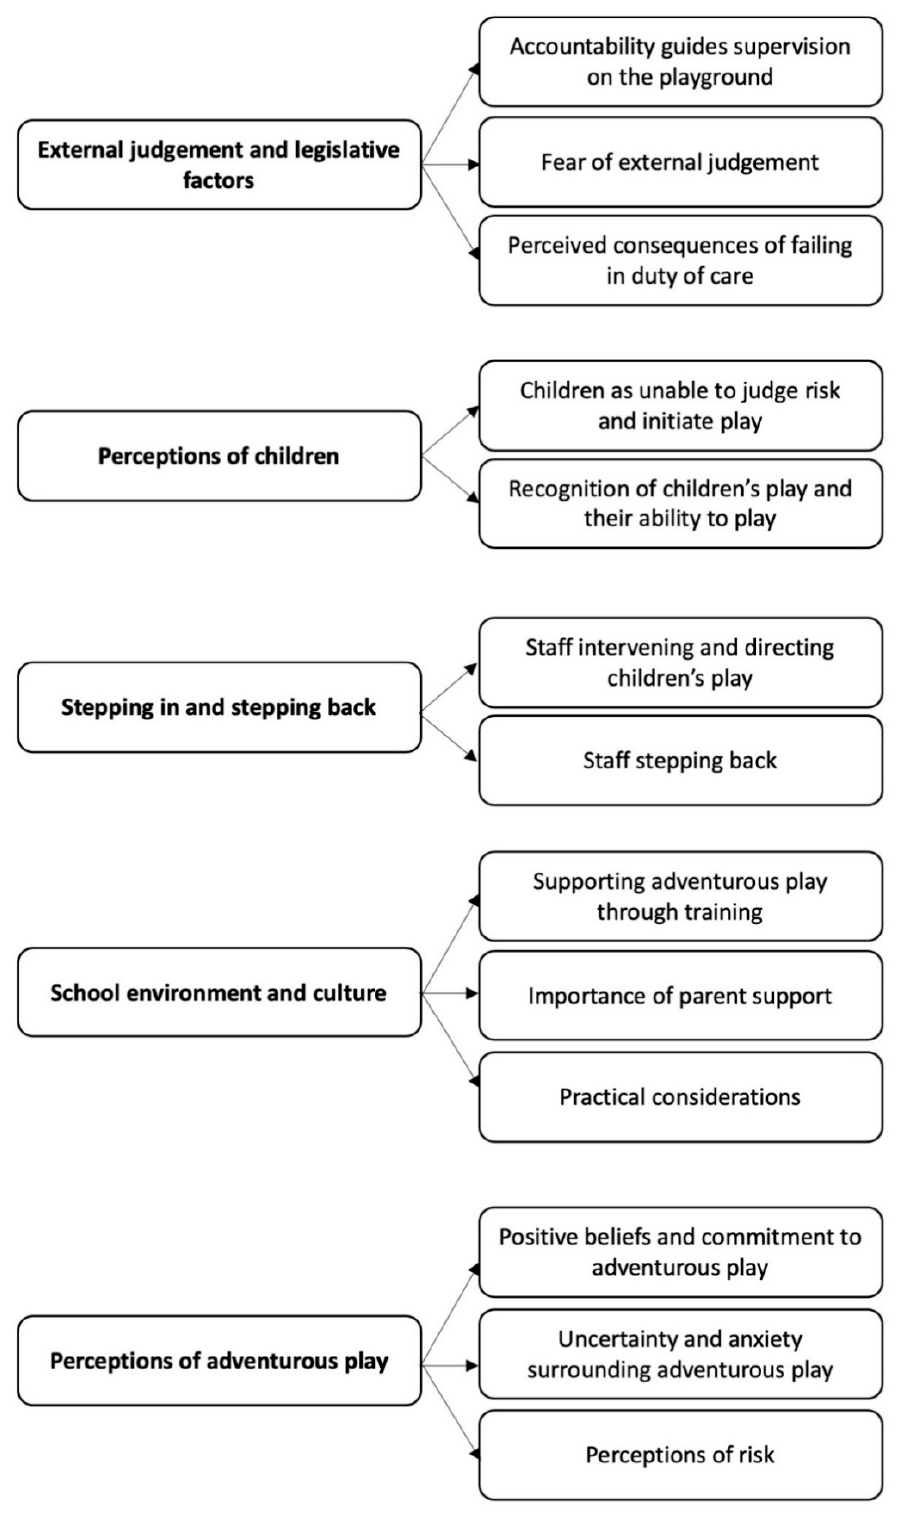
Figure 2. The five synthesised findings and the aggregated categories within.